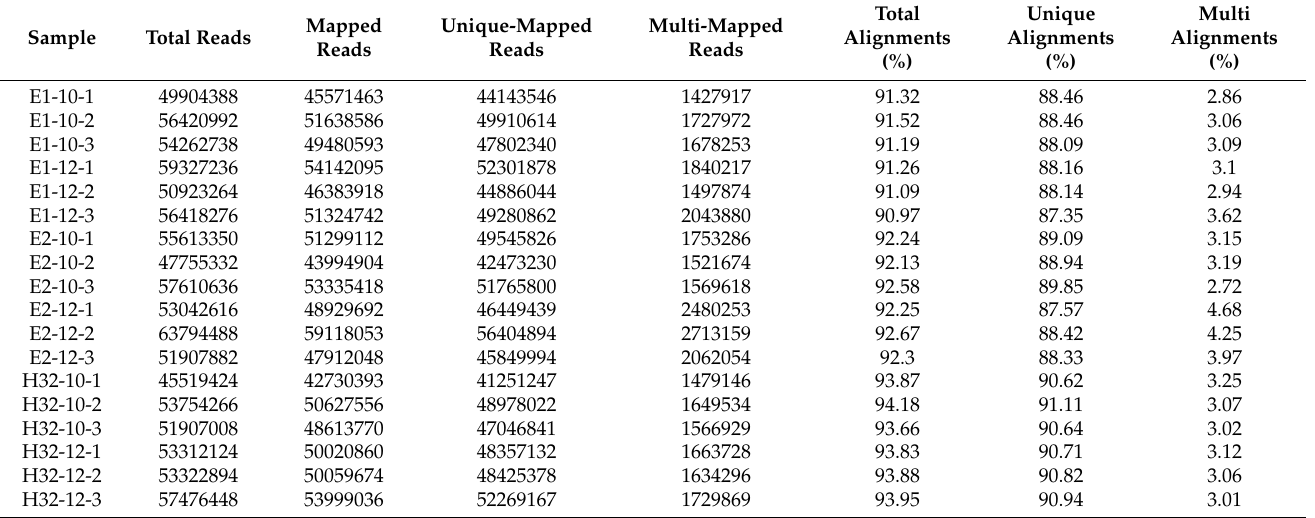
Table 1. The statistics of alignment between transcriptome data and the reference genome of culti- vated